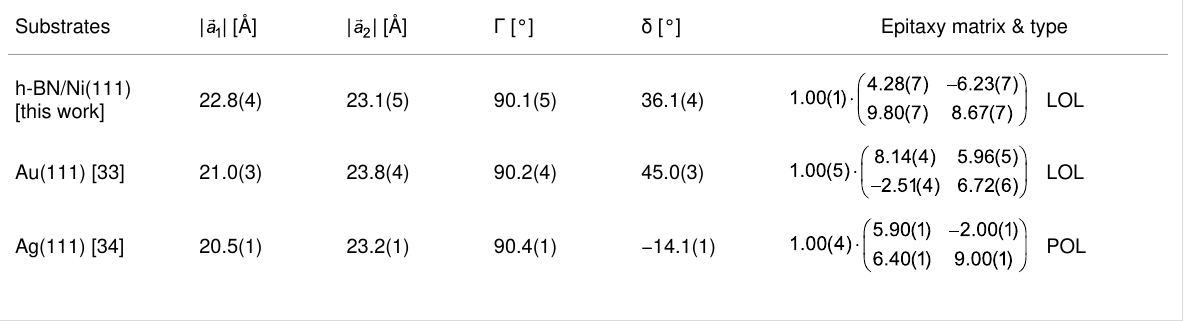
Table 1: Comparison of the lattice parameters obtained by our LEED analysis with reference data of DBP on Au(111) (1 MLE) [33] and on Ag(111) (1.3 MLE) [34]. The angle Γ is defined between the lattice vectors of the adsorbate and . The angle between the adsorbate lattice vector and the direction of the substrate lattice vector is labeled with δ . Before each epitaxy matrix a prefactor along with its margin of error indicates the absolute scaling uncertainty of the analyzed LEED image. Please note that the epitaxy matrix of DBP on Au(111) and on Ag(111) deviates from the matrix of DBP on h-BN/Ni(111) because of different lattice constants of the substrate as well as slightly different lattice parameters of the adsorbate. We used the acronyms POL and LOL (for point-on-line and line-on-line epitaxy) to characterize the type of epitaxy. The uncertainty of the numerical fitting procedure is given in parentheses behind each value and refers to the last significant